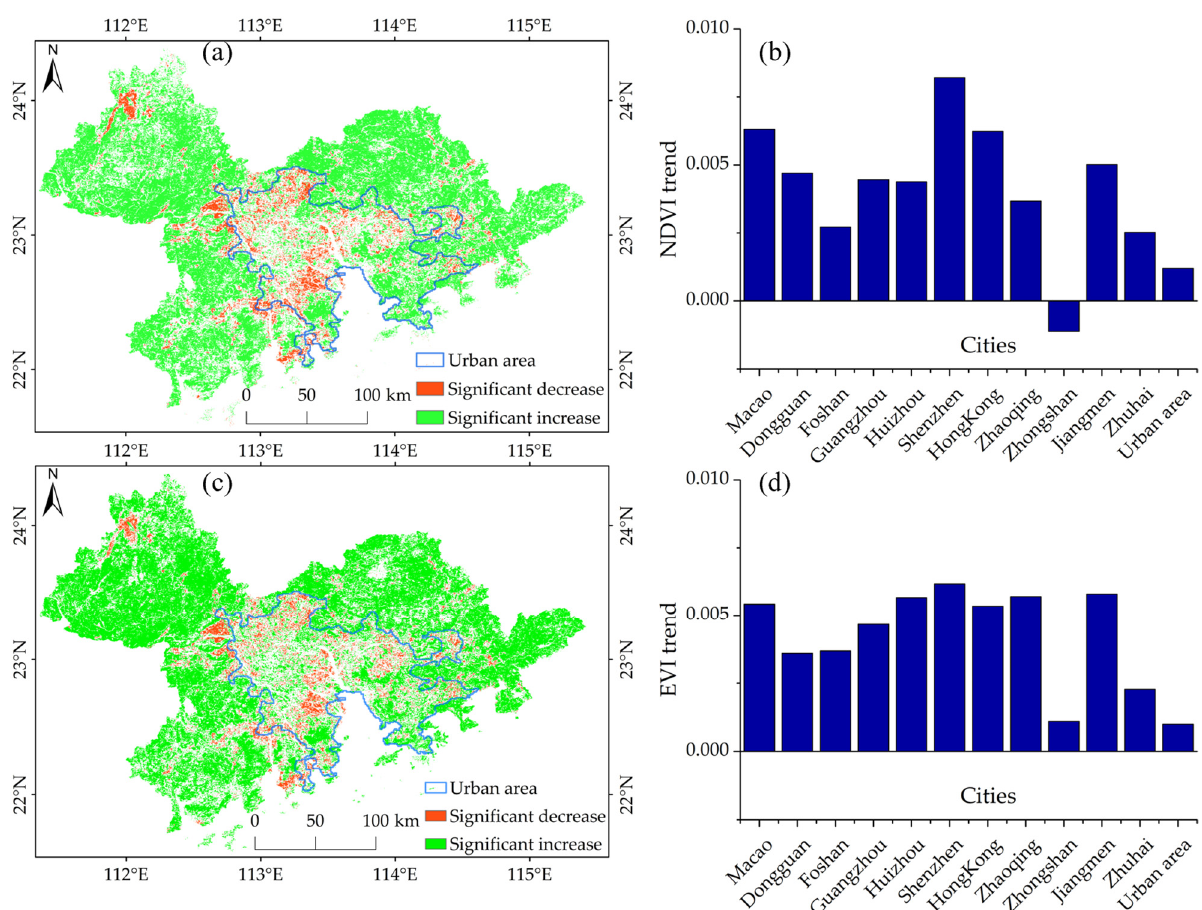
Figure 6. Spatial change trend for vegetation from 2000 to 2019. ( a , b ) denoted the gradual change based on NDVI; ( c , d ) denoted the gradual change type based on EVI.